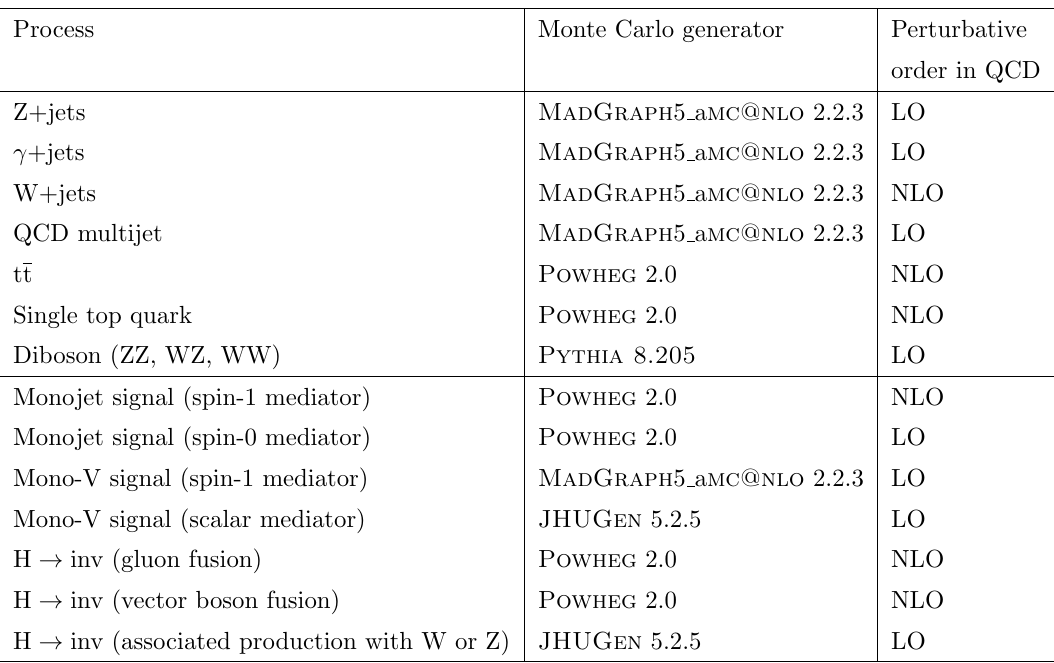
Table 1 . Monte Carlo generators used for simulating various signal and background processes.